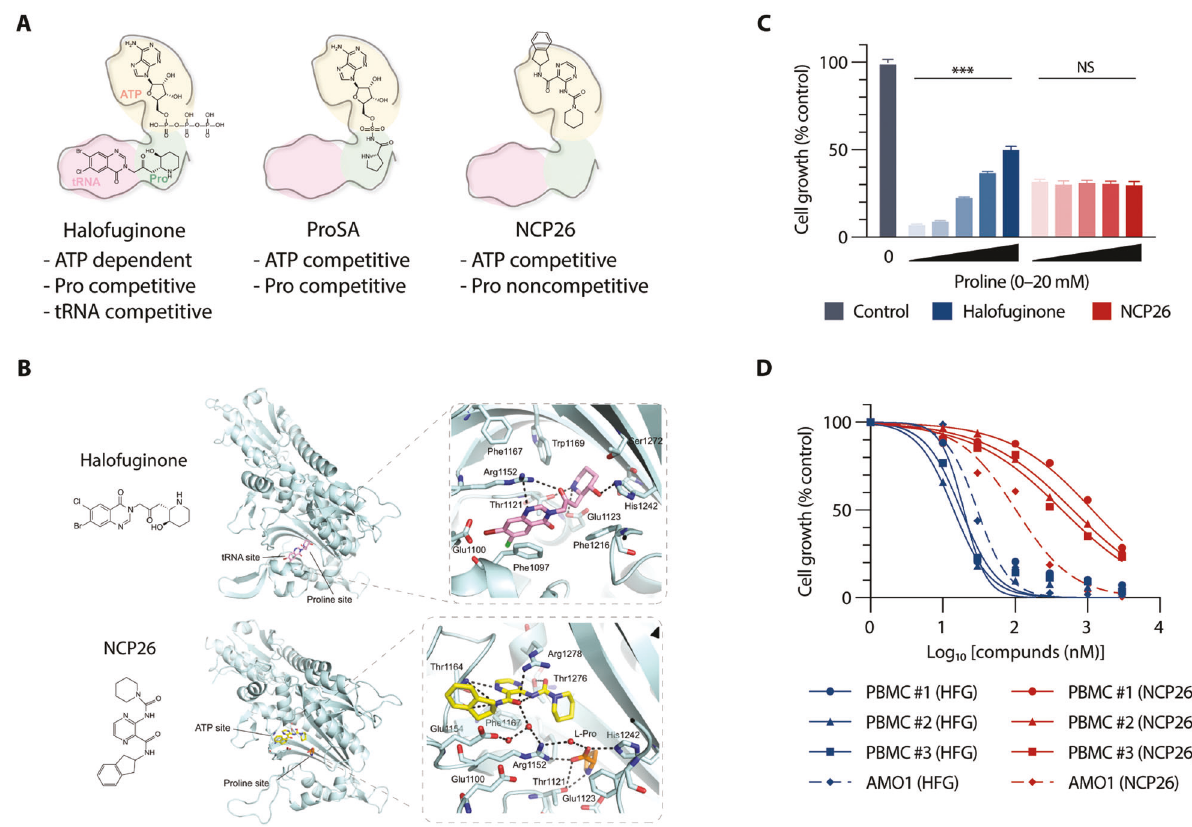
Fig. 2 NCP26 is a novel PRS inhibitor chemotype that occupies the ATP pocket. A Schematic depiction of PRS inhibitor chemotypes and mode of inhibition: pink — tRNA binding site, light green — proline binding site, olive — ATP binding site. B Crystal structures illustrating inhibitor binding modes against human PRS. Inhibitors in complex with human PRS (HFG (PDB ID 4K87; NCP26 PDB ID 7BBU) are shown as coloured stick representations. Key interacting PRS residues are shown in light cyan. C AMO1 cells were cultured with or without halofuginone (HFG, 0.5 µM) or NCP26 (0.5 µM) in the presence of proline (0, 1, 5, 10 and 20 mM) for 48 h. Data represent mean ± SD of triplicate cultures. *** P < 0.001. D PBMCs isolated from three healthy volunteers were cultured with NCP26 (0.01 – 10 µM) for 96 h. Data are mean ± SD viability, assessed by MTT assay of triplicate cultures, expressed as percentage of untreated cell lines from other hematological malignancies such as leukaemia and lymphoma (Supplementary Fig. S1H). The cellular components in the BM microenvironment, includ- ing stromal cells, can protect MM cells from apoptosis induced by conventional therapeutic agents. Speci fi cally, IL-6 and IGF-1 are secreted factors that promote MM cell growth, survival, and drug resistance in the BM milieu [26]. We therefore fi rst examined whether NCP26 maintains its anti-proliferative effect against MM cells in the presence of exogenous IL-6 or IGF-1 and found that neither impacted NCP26 ’ s effects on the AMO1 and RPMI 8226 cell lines, as assessed by BrdU uptake (Fig. 3B). Next, AMO1 cells were cultured with increasing doses of NCP26 for 24 h in the presence